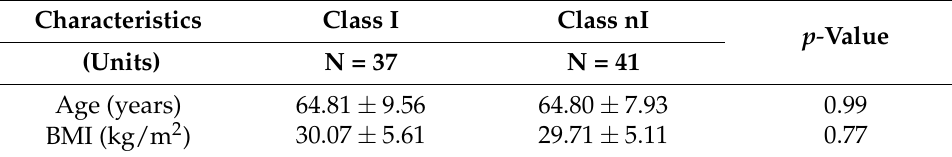
Table 2. Demographic characteristics of the male participants within each class.